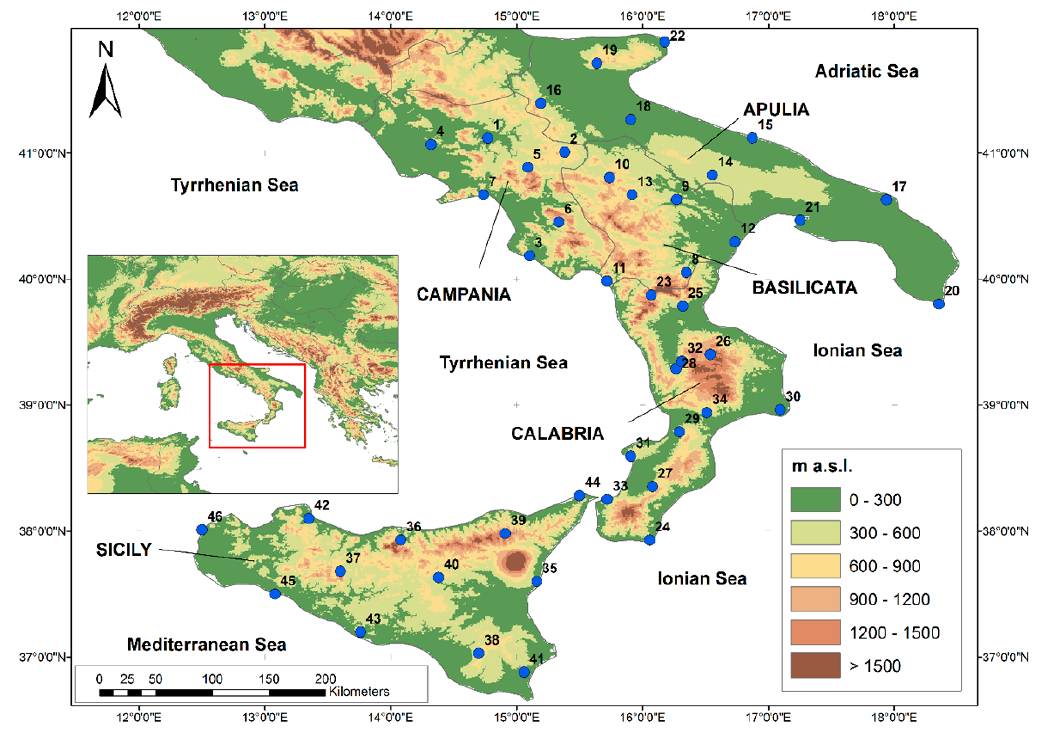
Figure 1. Study area with the locations of the 46 rain gauges.